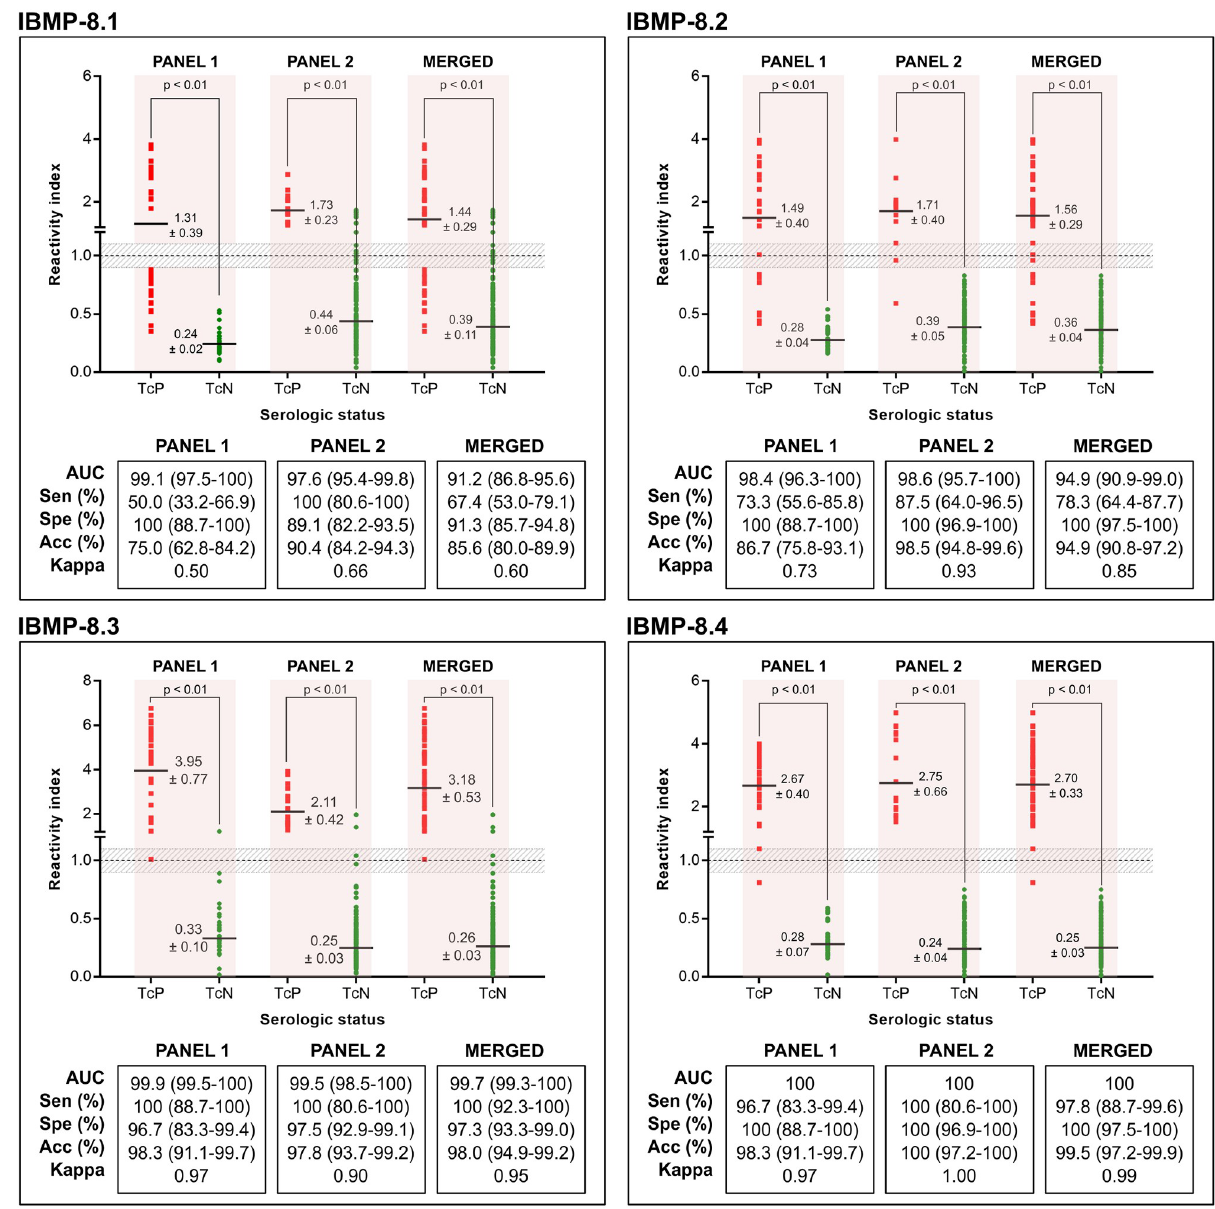
Fig 3. Reactivity index and diagnostic performance parameters obtained with serum samples from T . cruzi -infected and non-infected dogs. Panel 1 (dogs experimentally infected with Y, Berenice, and Colombian T . cruzi strains); Panel 2 (dogs naturally infected with unknown T . cruzi strains). The cut-off is set at the reactivity index value = 1.0 and the shadowed area represents the grey zone (RI = 1.0 ± 0.10). Horizontal lines and numbers for each result group represent the geometric means ( ± 95% CI). Acc (accuracy); AUC (area under curve); Sen (sensitivity); Spe (specificity); TcP ( T . cruzi -positive samples); TcN ( T . cruzi -negative